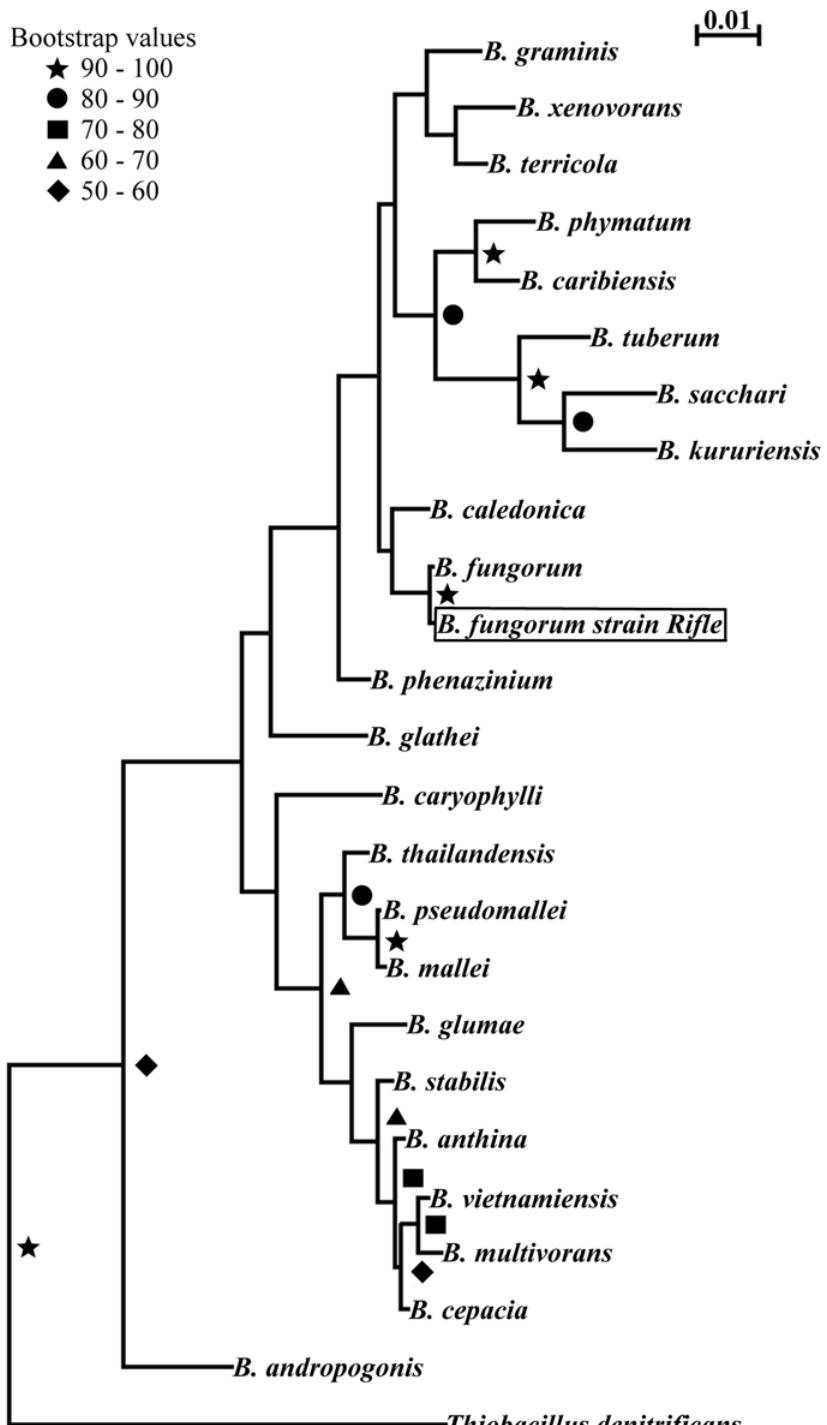
Fig 4. Maximum likelihood phylogenetic tree re-construction of Burkholderia type strains using 1366 bp of unambiguously aligned sequence of the 16S rRNA gene. Burkholderia fungorum strain Rifle is